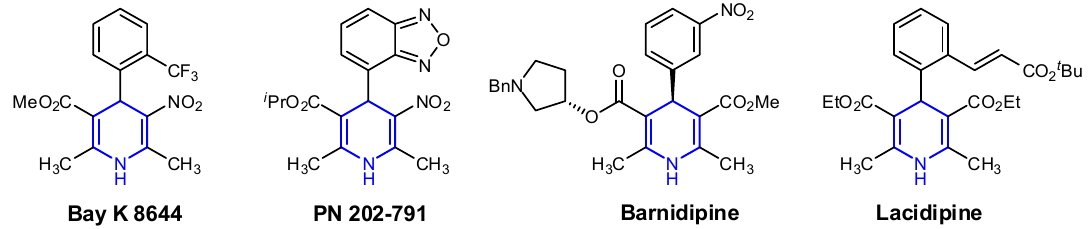
Figure 1. 1,4-Dihydropyridine based drugs as calcium channel blockers.